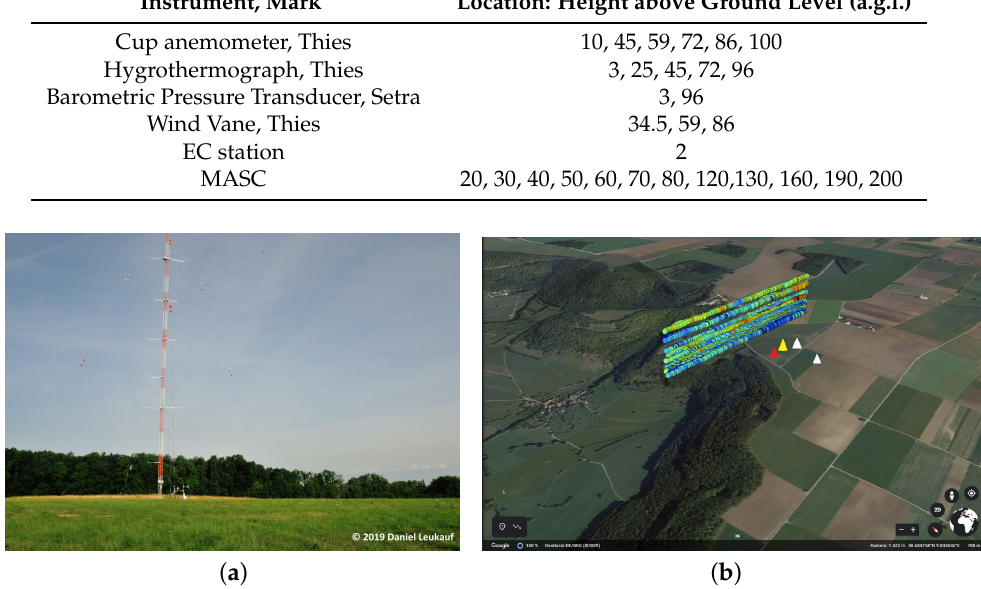
Figure 2. ( a ) View of the tower taken from east-southeast. To the west the tower is a dense canopy. This picture shows that the lowest anemometer (10 m) and the EC-station are directly downslope of the forest; ( b ) the flight patterns performed over the two days in September 2018. The colors along the legs indicate the measured horizontal wind speed. The red triangle marks the position of the tower and the yellow one is the EC-station. The white triangles are the future locations of the wind